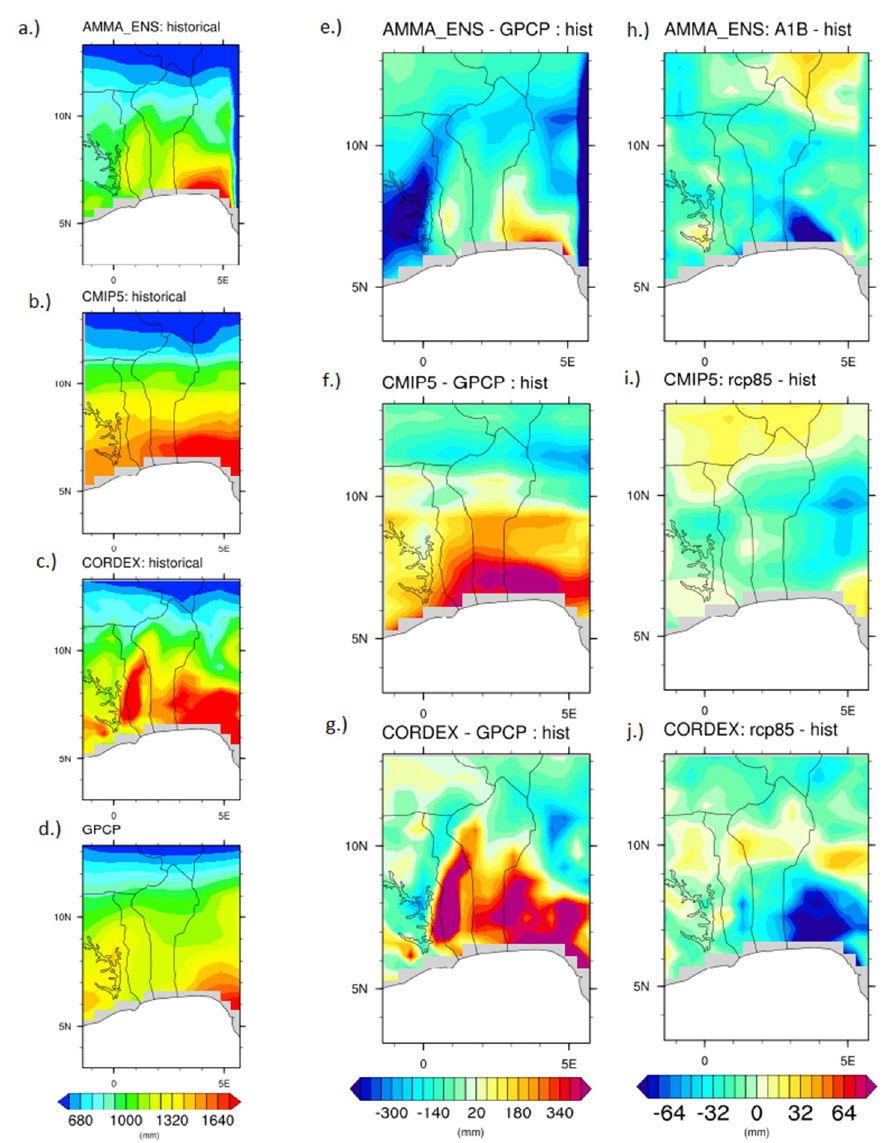
Figure 2. Ensemble average annual mean rainfall for 1988–2005 (first column), validation (second column over 1988–2005 period), and the projected changes with respect to the period 2028–2050 (third column).